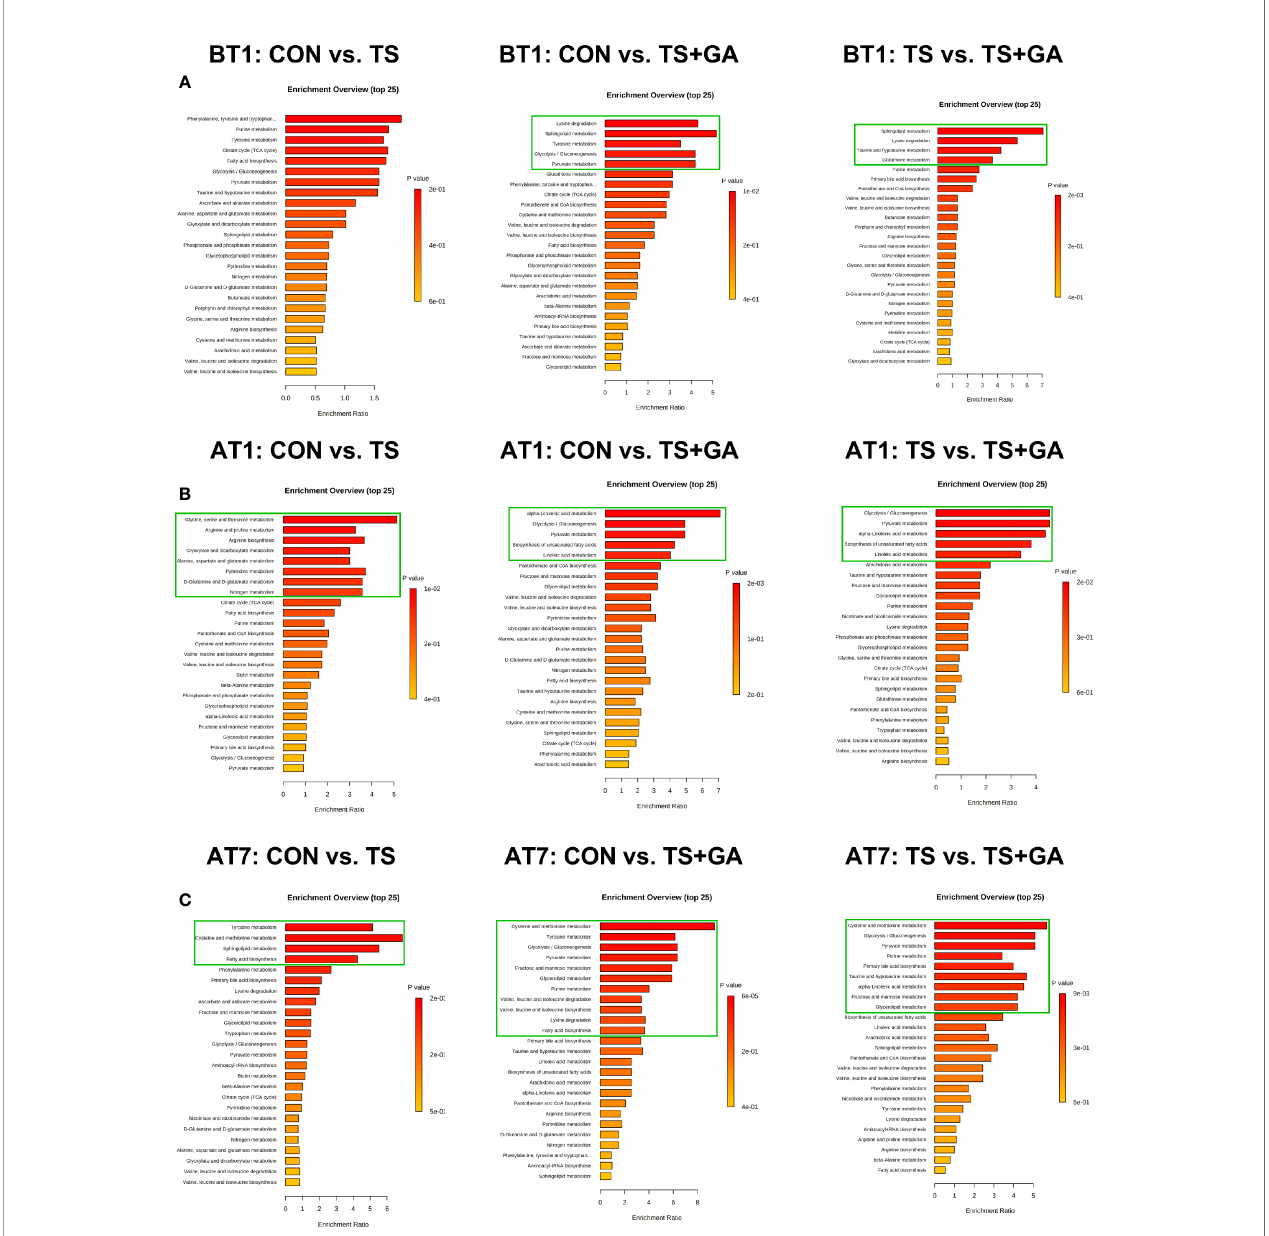
FIGURE 9 | Bar charts of the metabolic pathway analysis of differential serum metabolites on BT1 (A) , AT1 (B) , and AT7 (C) (n = 6 or 7). The pathway enrichment analysis shows all matched pathways, and the green boxes indicate signi fi cant metabolic pathways ( p < 0.05). BT1, the 1st day before transportation; AT1, the 1st day after transportation; AT7, the 7th day after